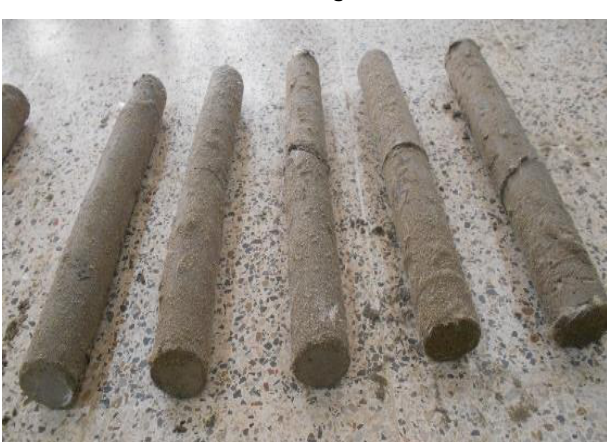
Fig. 8. Damaged Columns after the Application of Dynamic